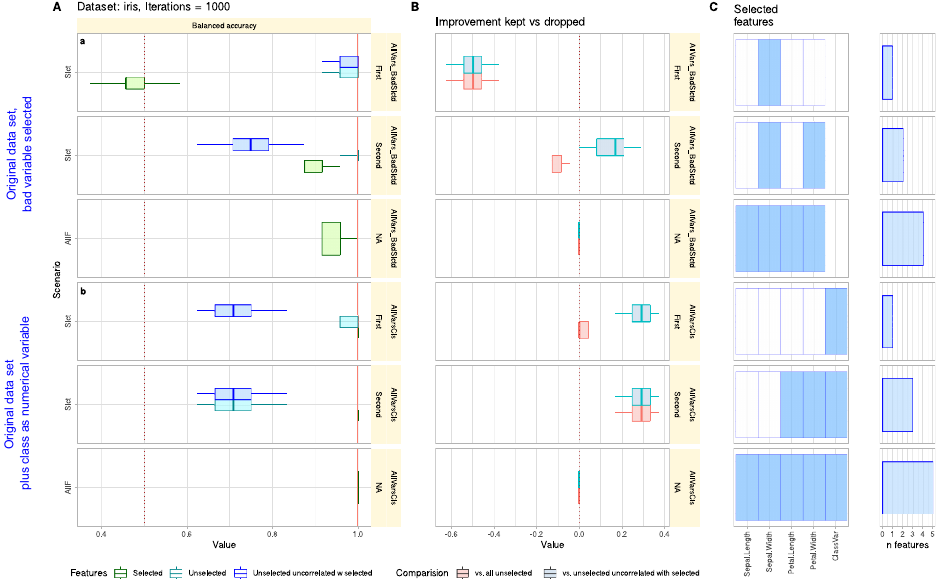
Figure 2. Feature selection and classification performance evaluation with different feature sets in the iris data set [28]. The graph is divided into subgraphs a–b from top to bottom. Experiments were performed ( a ) with the original data but sepal length was defined to be selected in a first run of feature selection, ( b ) with the iris data set where the class information was added as a numerical variable. Each subgraph is organized in three further subgraphs, showing from top to bottom (i) the results when using the features selected in the default feature selection, (ii) the features added when performing a second feature selection on the unselected features from the first selection, and (iii) when training the algorithm with the full feature set. The boxes show the 25th, 50th (blue vertical line), and 75th percentiles of balanced accuracies obtained in 1000 repeated runs with a random selection of 67% from the training data set and 80% from a validation data set separated from the data set before feature selection. Whiskers span the 95% confidence interval from the 2.5th to the 97.5th percentiles. ( A ): Balanced accuracy obtained with a random forests classifier trained with (i) the selected features, (ii) the unselected features, and (iii) the unselected features that were not highly correlated with the selected features, with the correlation threshold set at a very strong correlation of ρ > 0.9. ( B ): Difference in balanced accuracy when algorithms were trained with the selected versus unselected features. ( C ): Selected features (blue) and unselected features